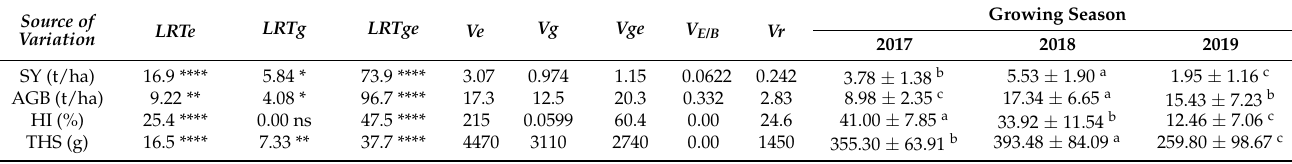
Table 2. Likelihood Ratio Test, Estimated Variance Components, and SY Mean of 12 Chickpea Accessions Evaluated for Three Consecutive Growing Seasons. Source of Variation